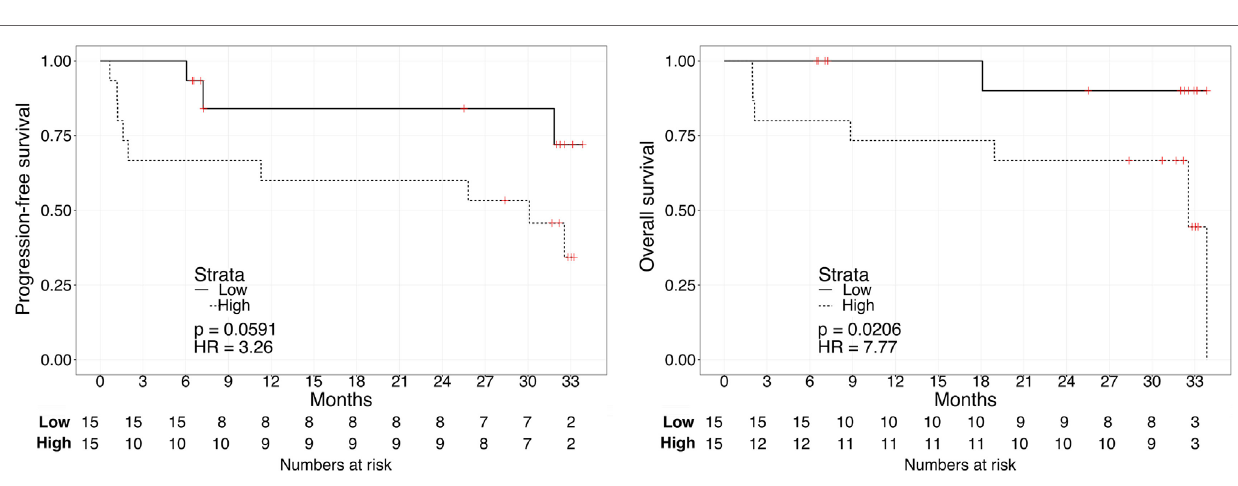
FigUre 2 | Kaplan–Meier curves for PFs (left) or Os (right) in ccrcc patients according to plasma biomarker score level . The prospective cohort of patients ( N = 30) was classified as 15 “Low” (solid) vs. 15 “High” (dashed) biomarker score at the time of sampling.